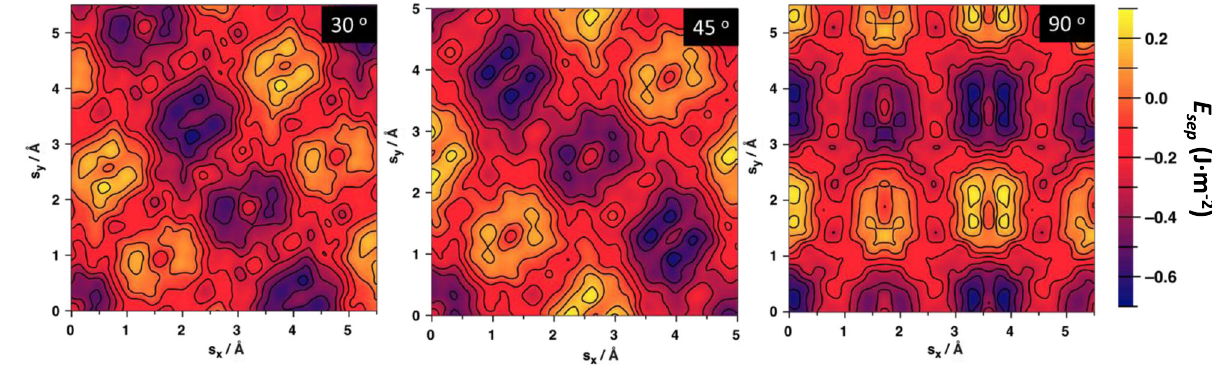
Fig.3|Effectoftwistangleoninterfacedisplacementmaps. E sep displacementmapsfor α =30°,45°,and90°(fromlefttoright)withrespecttothe x and y components of the shifting vector s .